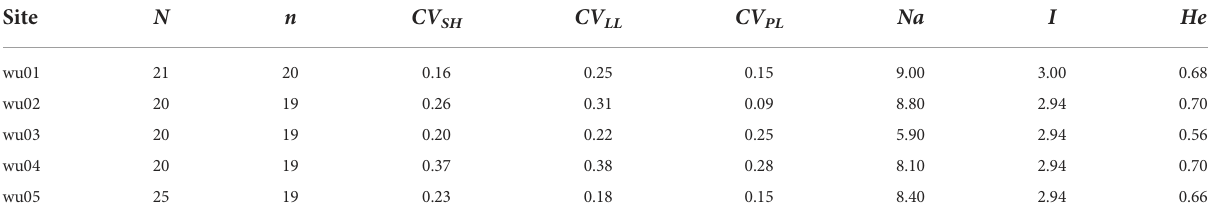
N denotes the number of total surveyed samples in the fi eld, n denotes the number of genotyped samples with nuclear microsatellites, CV SH denotes the coef fi cient of variation of shoot height,CV LL denotesthecoef fi cientofvariationofleaflength,CV PL denotesthecoef fi cientofvariationofpaniclelength,Nadenotesthenumberofalleles,IdenotesShannon ’ sinformation index, He denotes the expected heterozygosity.